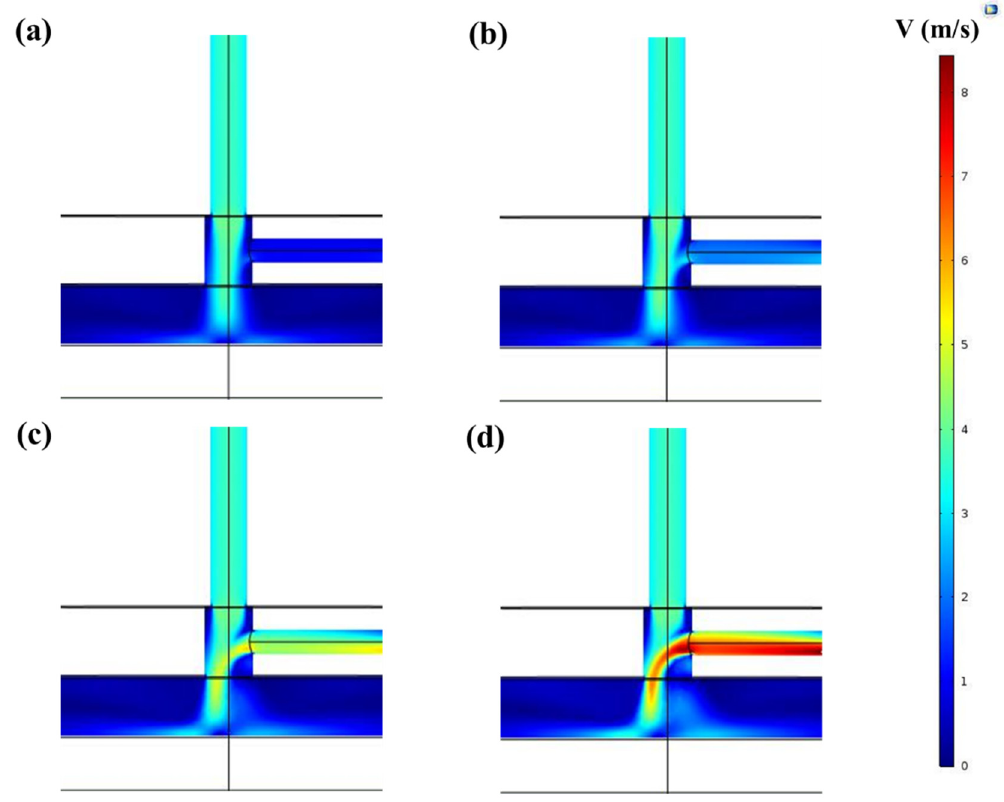
Figure 5. Velocity distribution (m / s) in the XZ-plane at a 5 mm gap size between the capillary and the substrate for a sideway gas flow rate of ( a ) 125 sccm, ( b ) 250 sccm, ( c ) 500 sccm, and ( d ) 750 sccm.